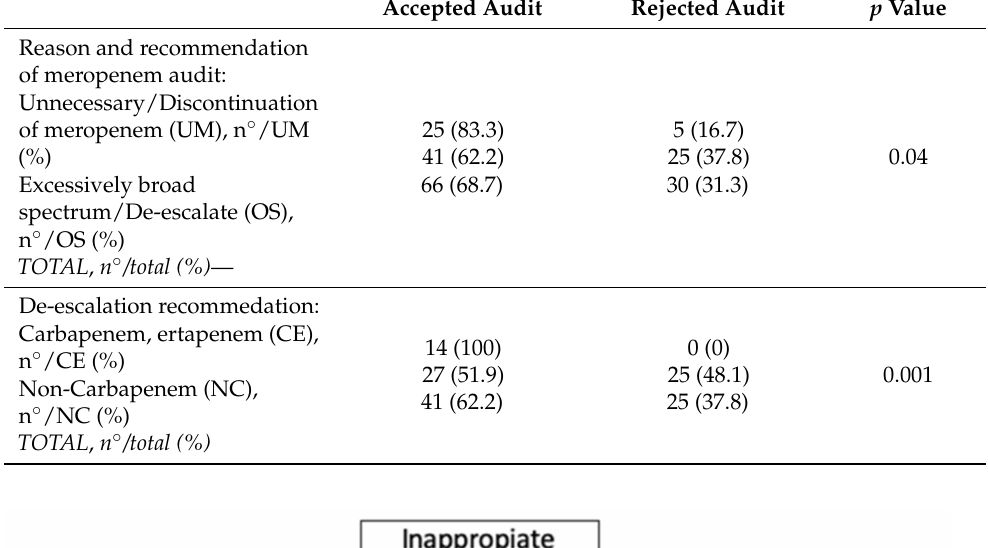
Table 3. Antimicrobial Stewardship Program intervention data.